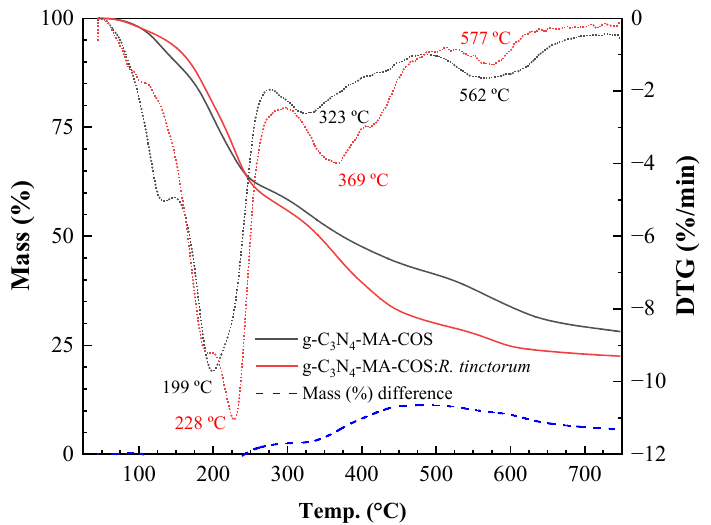
Figure 3. TG (left axis) and DTG (right axis) thermograms of g-C 3 N 4 -MA-COS NCs: empty NCs (black lines), NCs loaded with R. tinctorum extract (red lines).